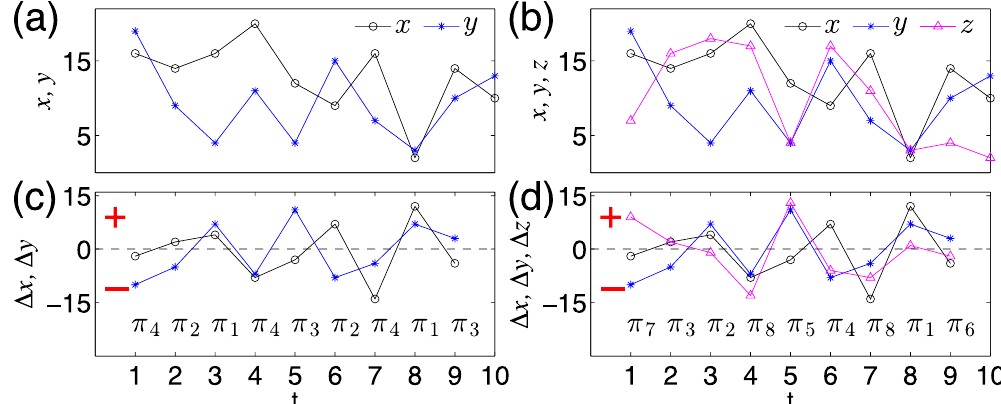
Figure 1. Order pattern definitions for ( a ) two dimensional series ( x ( t ), y ( t )) and ( c ) its increment series ( Δ x ( t ), Δ y ( t )). ( b ) Three dimensional series ( x ( t ), y ( t ), z ( t )) and ( d ) the corresponding increment series ( Δ x ( t ), Δ y ( t ), Δ y ( t )). Signs of the increment series and the ordinal patterns are respectively indicated in ( c , d ).